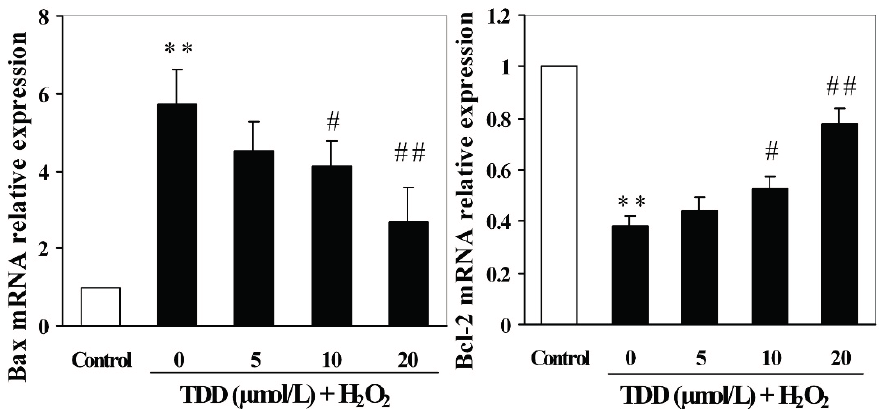
Figure 5. Effects of 2,4 ′ ,5 ′ -trihydroxyl-5,2 ′ -dibromo diphenylmethanone on the expression of Bcl-2 mRNA and Bax mRNA in H 2 O 2 -induced EA.hy926 cells by real-time PCR. Data are presented as mean ± SD ( n = 3). ** p < 0.01 vs. control; # p < 0.05 and ## p < 0.01 vs. H 2 O 2 group.